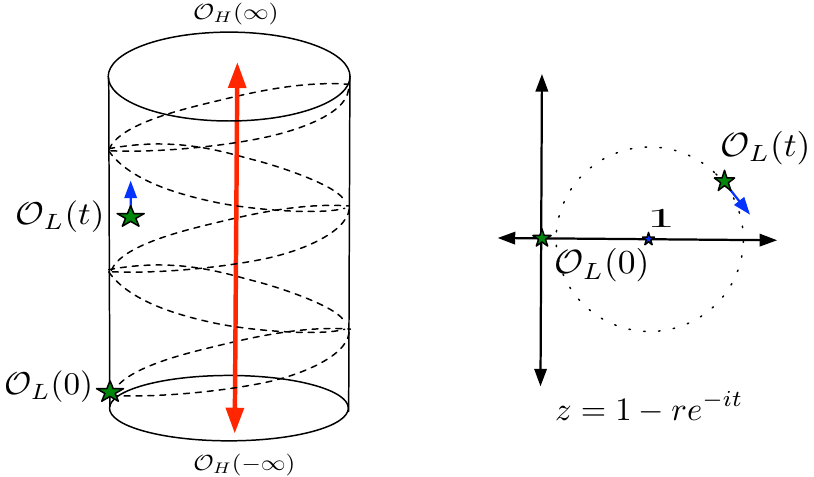
Figure 1 . This (cid:12)gure suggests the analytic continuations necessary to obtain a heavy-light cor- relator with increasing (Lorentzian) time separation between the light operators. We take r . 1 to avoid singularities on the lightcones displayed on the left; one can also use r as a proxy for a Euclidean time separation between the light